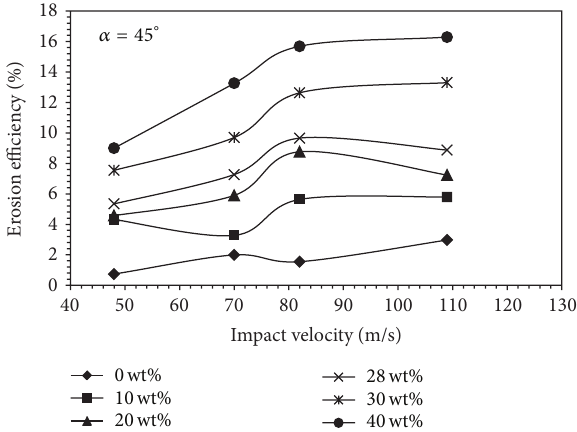
Figure 6: Erosion efficiency as a function of impact velocity for PVA/DPL